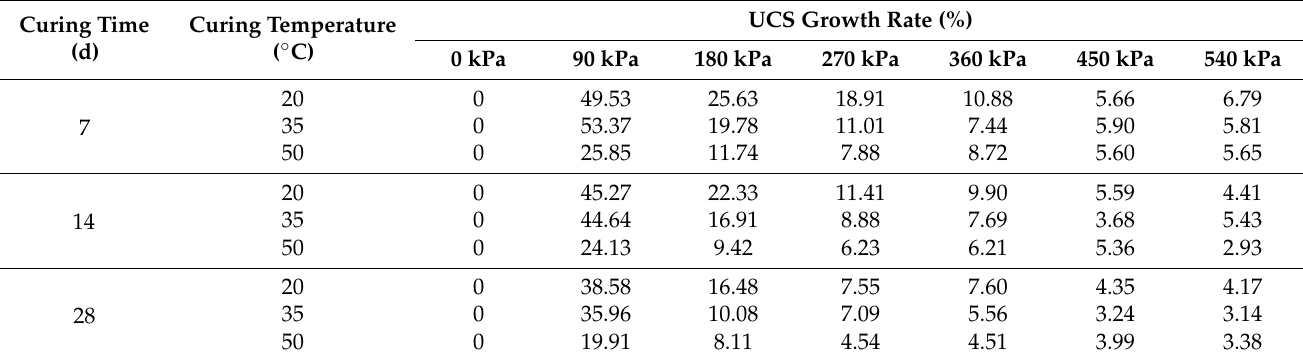
Table 2. The distribution of the UCS growth rate for